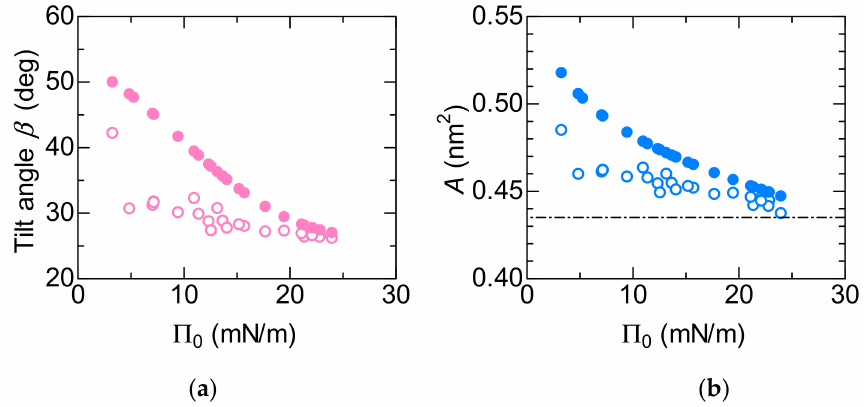
Figure 9. ( a ) Dependence of the tilt angle on Π 0 . Closed and open circles represent data for initial Π 0 and final Π 1 , respectively; ( b ) Dependence of the molecular area A on Π 0 . Closed and open circles represent data for A 0 and A 1 , respectively. The horizontal dashed line shows the minimum molecular area at low temperature [20].